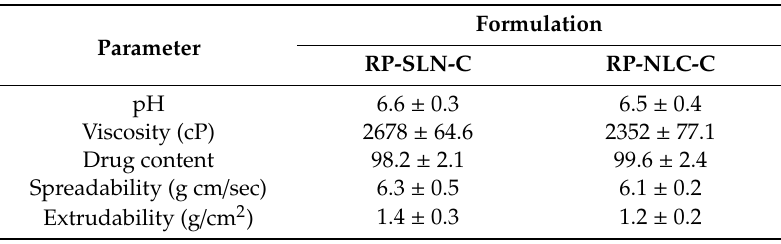
Table 3. pH, viscosity, drug content, spreadability and extrudability of RP-SLN-C and RP-NLC-C hydrogel formulations (mean ± SD, n =